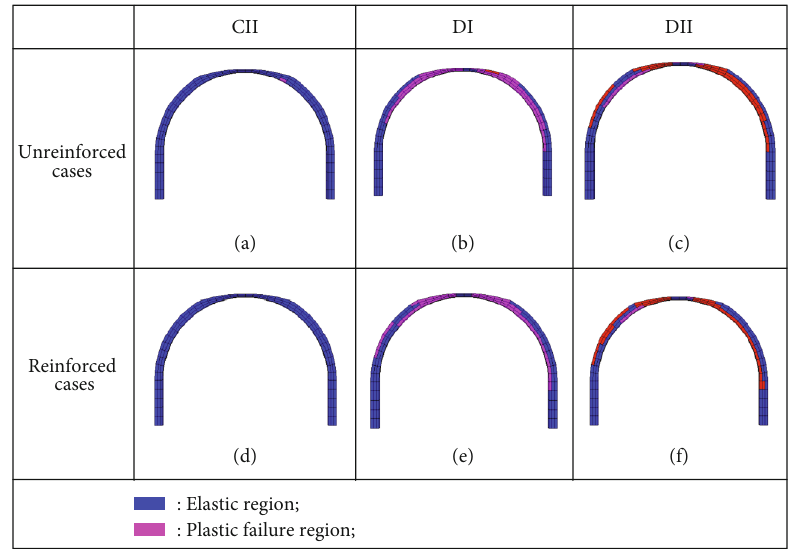
Figure 13: Plastic failure region on lining concrete for tunnel with a cavity on the crown.